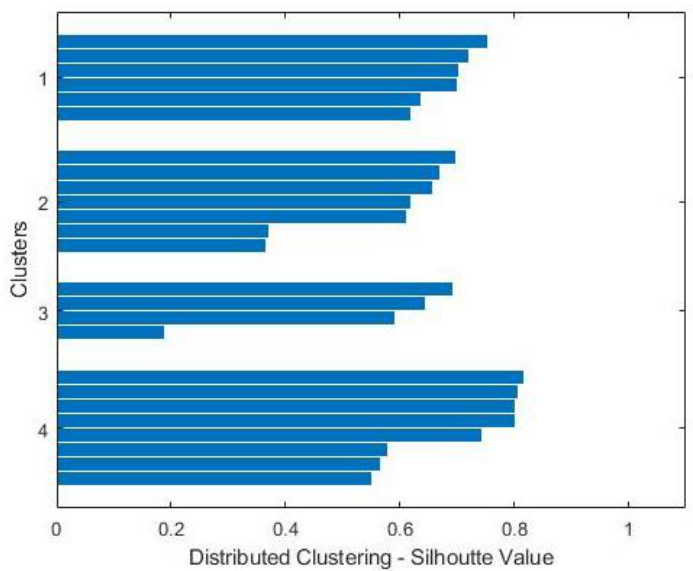
Figure 6. Silhouette representation of distributed clustering of LSBSs.